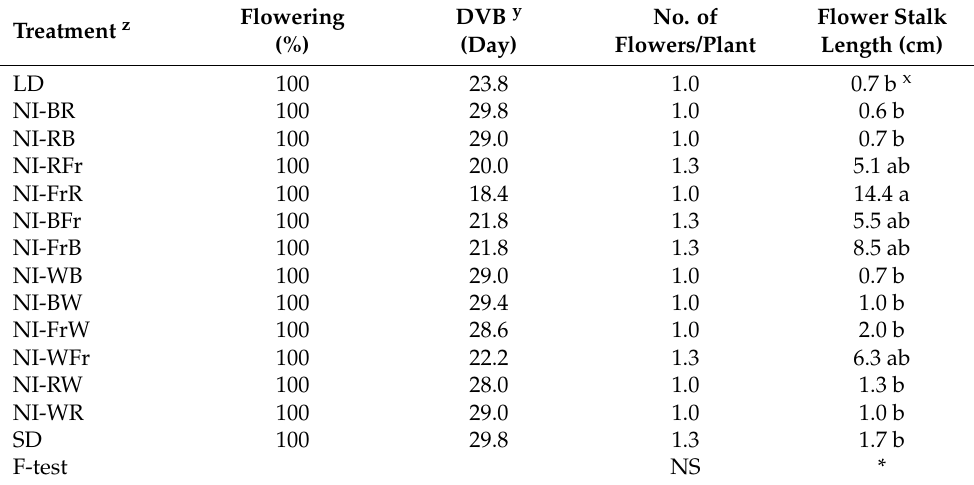
Table 3. Effects of 10 µ mol · m − 2 · s − 1 PPFD night-interruption light (NIL) quality shifting on flowering characteristics of geranium ( Pelargonium × hortorum L.H. Bailey ‘Ringo 2000 Violet’) measured 40 days after treatment.